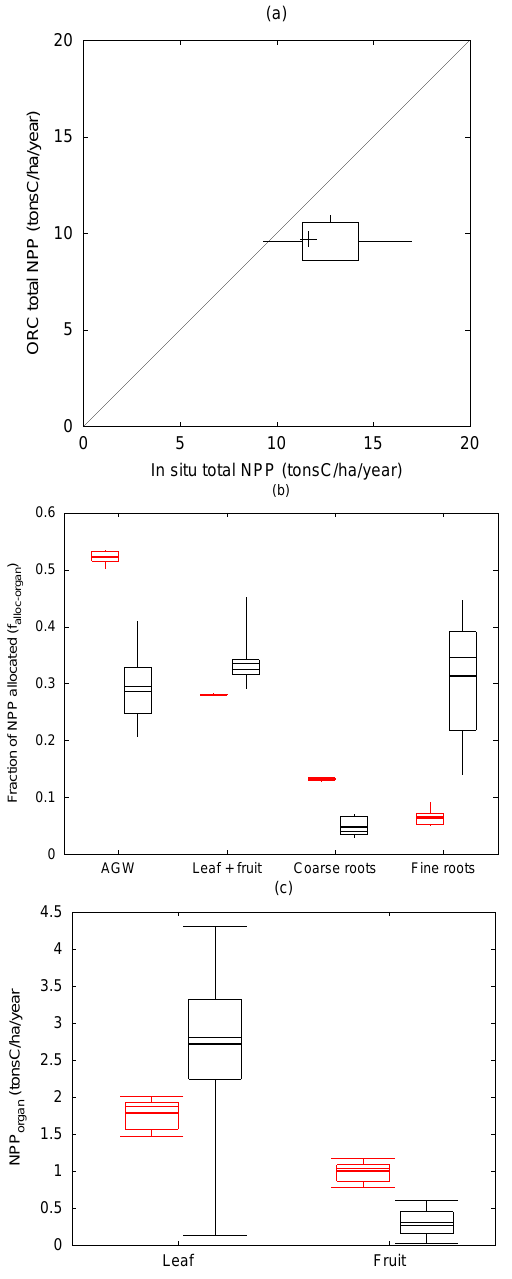
Fig. 3. Comparison of ORCHIDEE allocation with ground mea- surements. (a) Total Net Primary production; (b) Fraction of allo- cation of total NPP between organs ( f alloc − organs ): Above Ground Wood (AGW), Leaf and fruit, Coarse Roots, Fine Roots (c) NPP allocated to leaf and fruit. Ground measurements for (a) and (b) are for 10 sites (Arag˜ao et al., 2009). Ground measurements for (c) are based on litterfall measurements made for 62 sites (Chave et al., 2010). For each x-axis class: the vertical box represents the 25 and 75 percentiles; median in represented by a light line; average is rep- resented by a bold line; whiskers extremities show the minimum and maximum values. In (b) and (c), red is for ORCHIDEE outputs and black for the ground